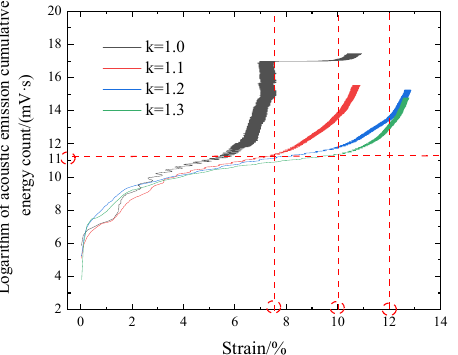
Figure 17. The AE cumulative energy count versus strain for di ff erent peak stress ratios.